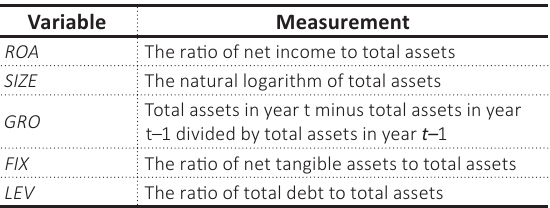
Table 2. Study variables and their measurement